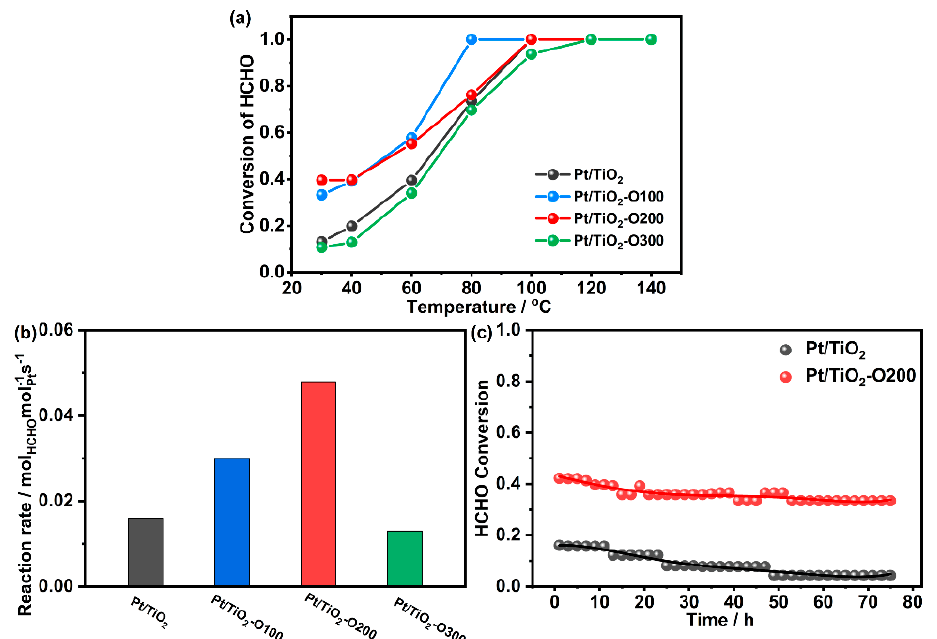
Figure 1. Formaldehyde (HCHO) conversion as a function of reaction temperature ( a ), reaction rate at 30 °C ( b ) of various Pt/TiO 2 catalysts, and stability test ( c ) of pristine Pt/TiO 2 and Pt/TiO 2 pre-oxidized at 200 °C.